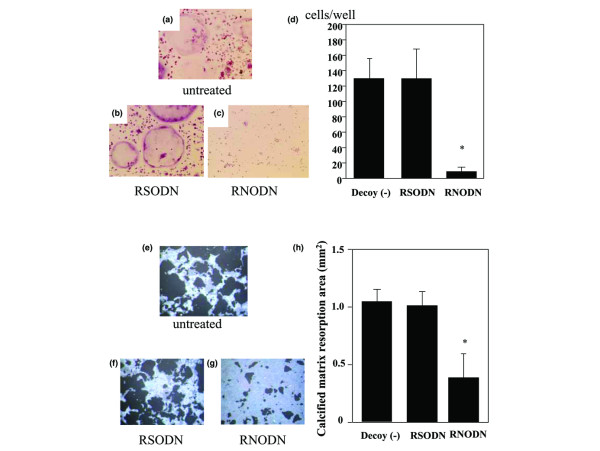
Osteoclast differentiation induced in vitro by macrophage colony-stimulating factor and RANKL. Cells were transiently transferred with ribbon-type scrambled decoy oligodeoxynucleotide (RSODN) (b) or ribbon-type NF-κB decoy oligodeoxynucleotide (RNODN) (c), or were untreated alone (a). Original magnification × 100. (d) Numbers of TRAP-positive multinuclear cells. (n = 5 per group; *p < 0.001, compared with rats treated with RSODN.) (e-h) Calcified matrix resorption by osteoclast-like cells induced by soluble receptor activator of nuclear factor κB ligand (RANKL). Cells were transiently transferred with RSODN (f) or RNODN (g) or were untreated alone (e). (h) Mean calcified matrix resorption areas calculated by MacSCOPE image analyzer. (n = 5 per group; *p < 0.01 compared with the RSODN-treated group.)